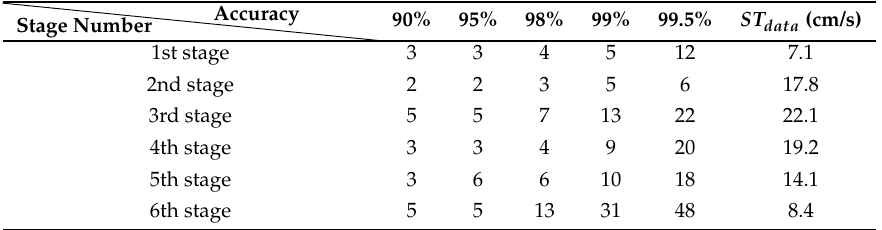
Table 3. The minimum number of modes required to reach a specified reconstruction accuracy in velocity data is shown for the cerebral aneurysm model. The spatiotemporal average of data ( ST data ) is shown for each stage.